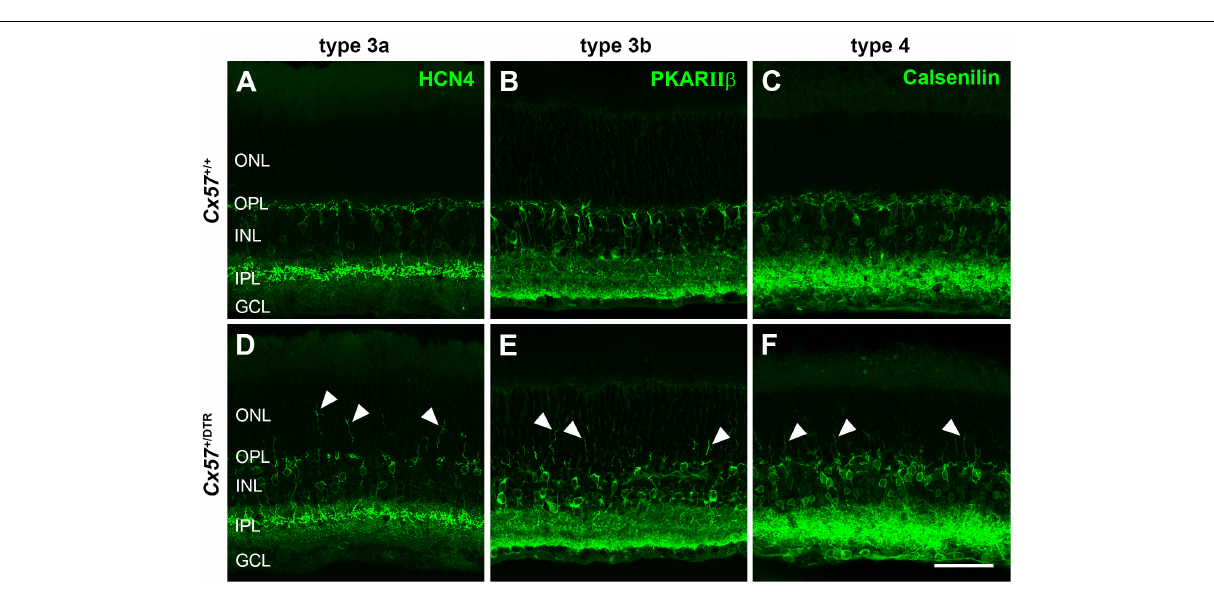
FIGURE 9 | OFF bipolar cells sprouted into the ONL. (A–F) Retinal sections from Cx57 + / + and Cx57 + / DTR retinae (P56) were stained for HCN4, PKARII β and calsenilin, markers for type 3a, 3b, and 4 OFF bipolar cells, respectively. While the dendrites of type 3a, 3b, and 4 OFF bipolar cells terminated in the OPL